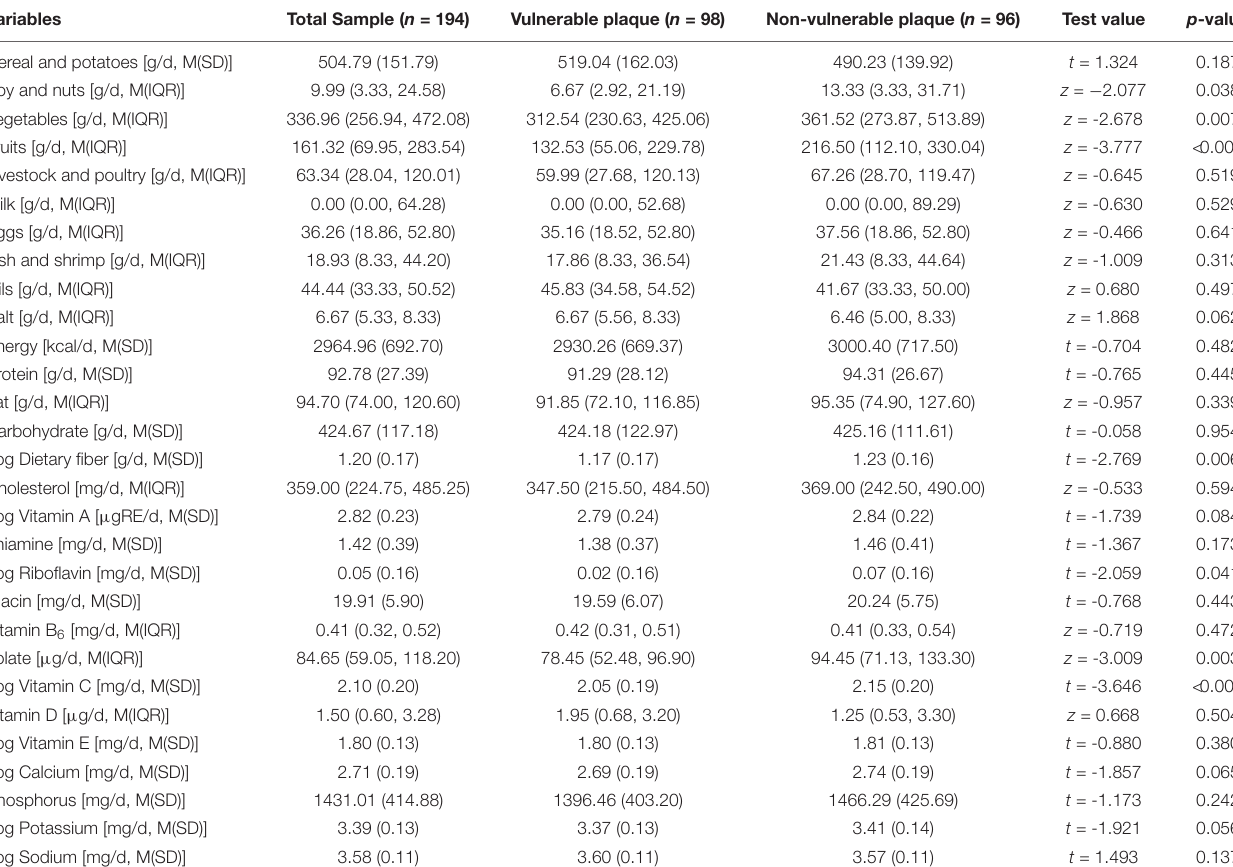
TABLE 3 | Dietary intake status of vulnerable plaque and non-vulnerable plaque patients ( N = 194). Variables Total Sample ( n = 194) Vulnerable plaque ( n = 98) Non-vulnerable plaque ( n = 96) Test value p